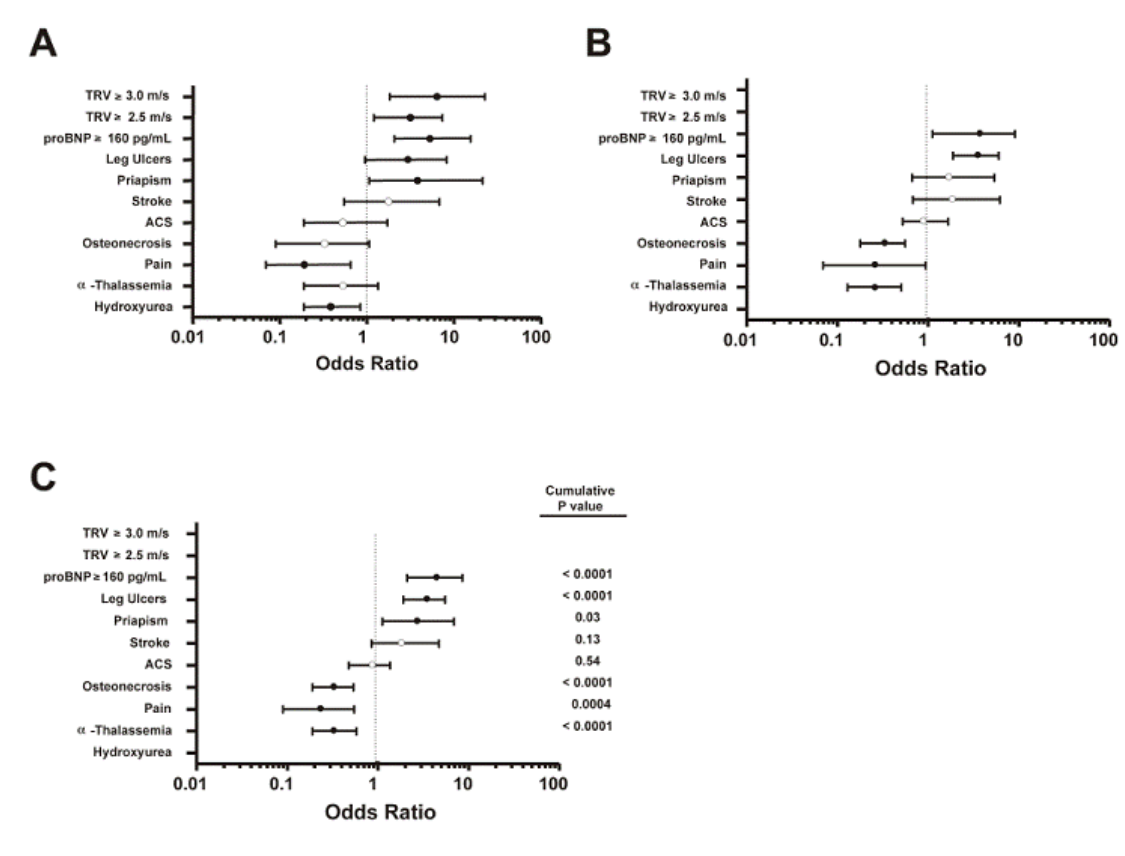
FIGURE 3. Clinical and laboratory findings in patients with sickle cell anemia dichotomized by LDH levels. The CSSCD group comprised 113 patients in the high LDH quartile and 111 cases in the low LDH quartile. The numbers in the NIH group were 64 and 62, respectively. (From Taylor et